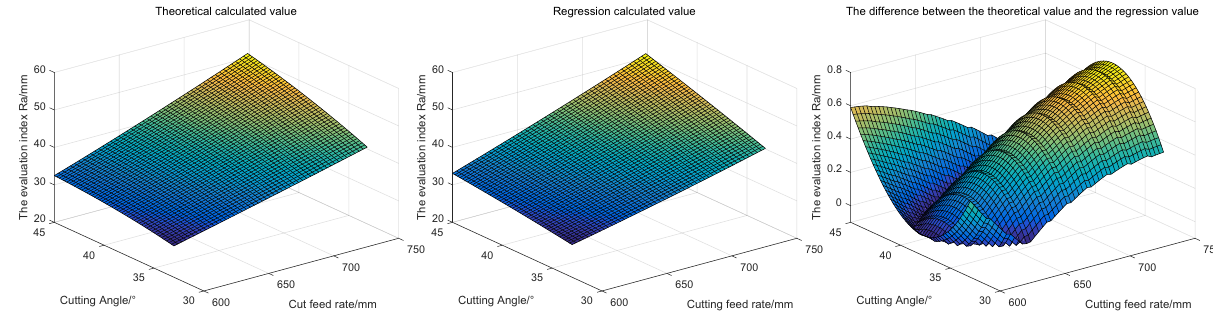
Figure 10. The influence of different cutting angles and cutting feed rate on the evaluation